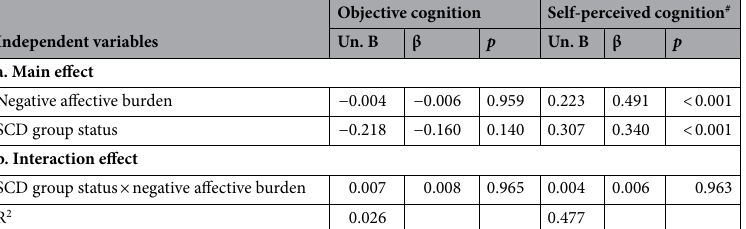
Table 3. Associations between negative affective burden and SCD status on objective and self-perceived cognitive functioning from the linear regression analysis. Group coded: SCD = 1, HC = 0. Un. B are unstandardized B values, β indicate standardized B values, R 2 represents the variance of the data which is explained by the model. HC healthy controls, SCD subjective cognitive decline. # Higher scores proportionally relate to lower self-perceived cognitive